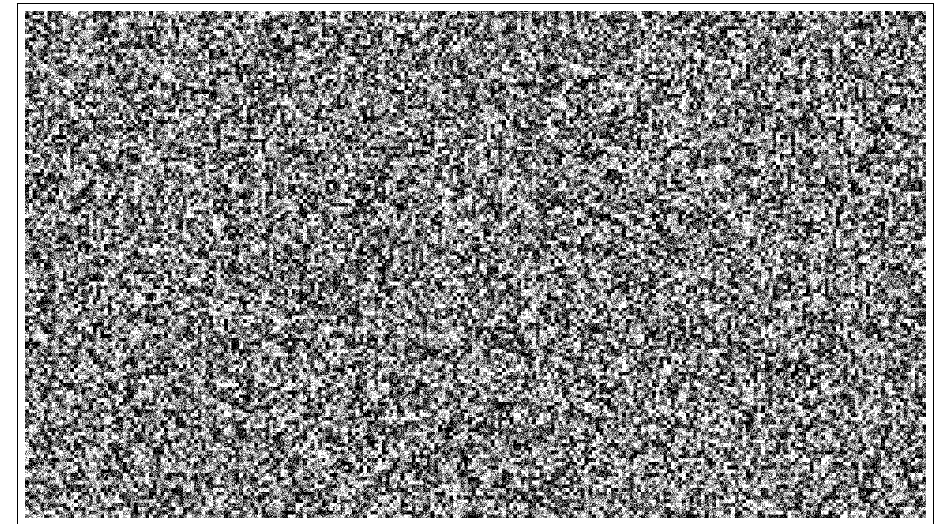
Figure 5. Realsense iPhone speck pattern for calibration